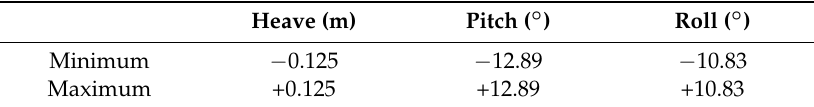
Table 1. Motion platform excursions for each individual